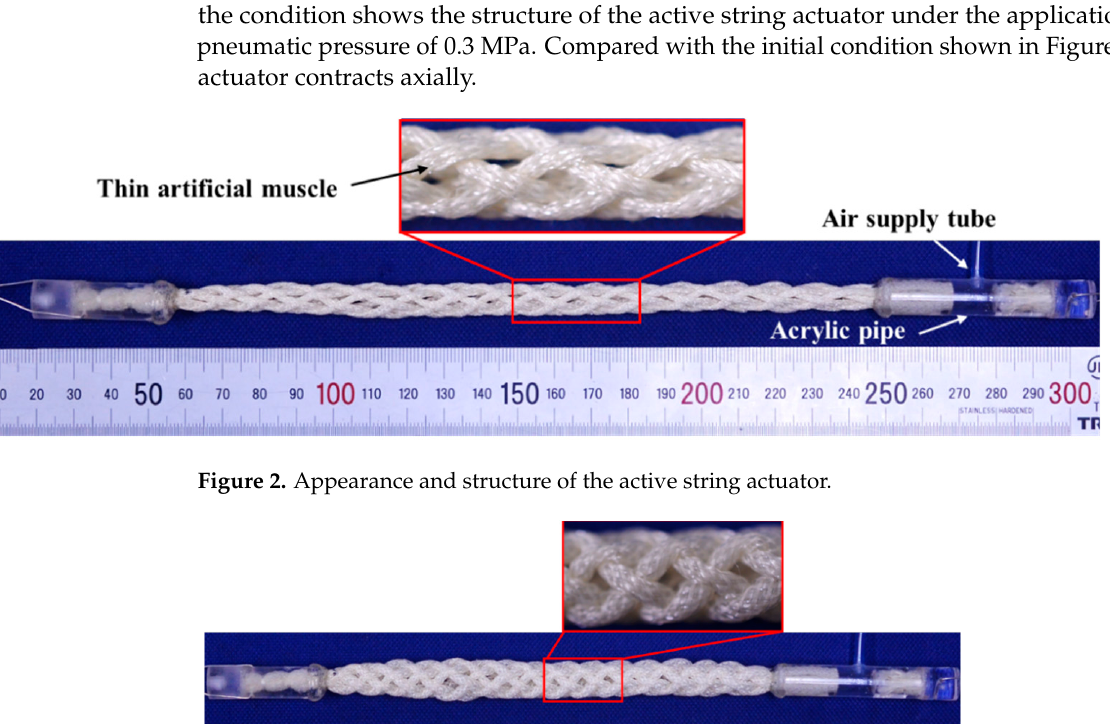
Figure 3. Active string actuator with air pressure of 0.3 MPa.